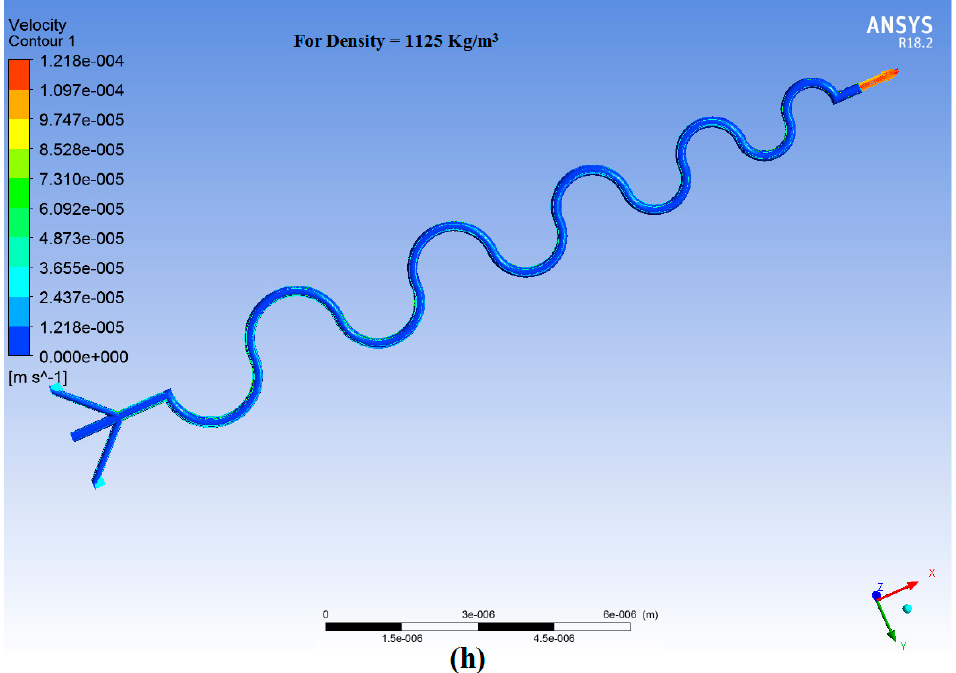
Figure 11. ( a – h ) Contours of Pressure and Velocity at different densities in the case of 5CDCMC. The graphical results of ANSYS Fluent are described below. For 5CACMC, the graph between Reynolds number and pressure drop is shown in Figure 12a and the graph between the Reynolds number and the flow rate is shown in Figure 12b. These graphs have four different lines in different colors. The red, blue, yellow and green lines are shown with blood density 950, 1000, 1060, and 1125 kgm − 3 , respectively. Data in Figure 12a shows that with the increase in Reynolds number, there is an increase in pressure drop. The maximum simulated pressure drop is 1.6 Pa. The pressure drop was calculated by the following equation.